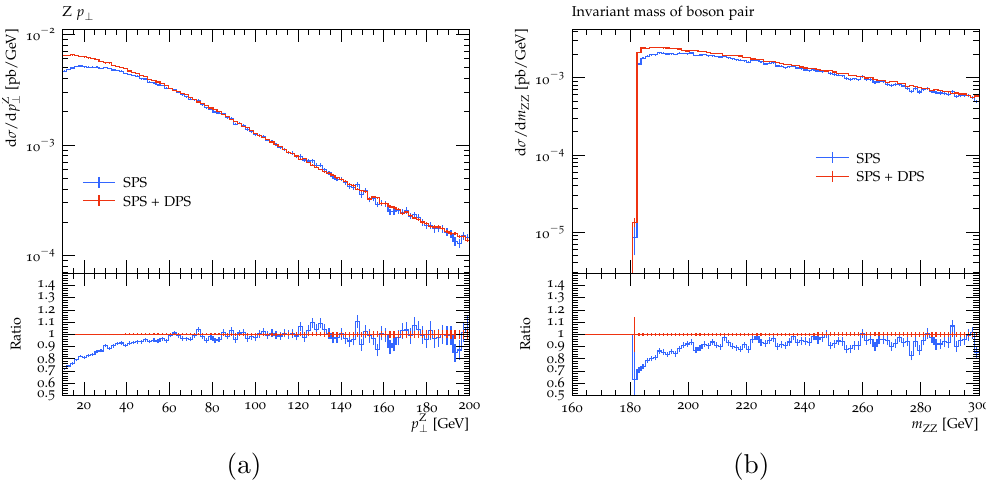
Figure 16 . (a) Transverse momenta of the Z 0 bosons and (b) invariant mass of the Z 0 Z 0 pair for the production via SPS only and via SPS combined with DPS. The SPS+DPS setup is the reference in the ratio plots. The histograms are not normalised to unity.